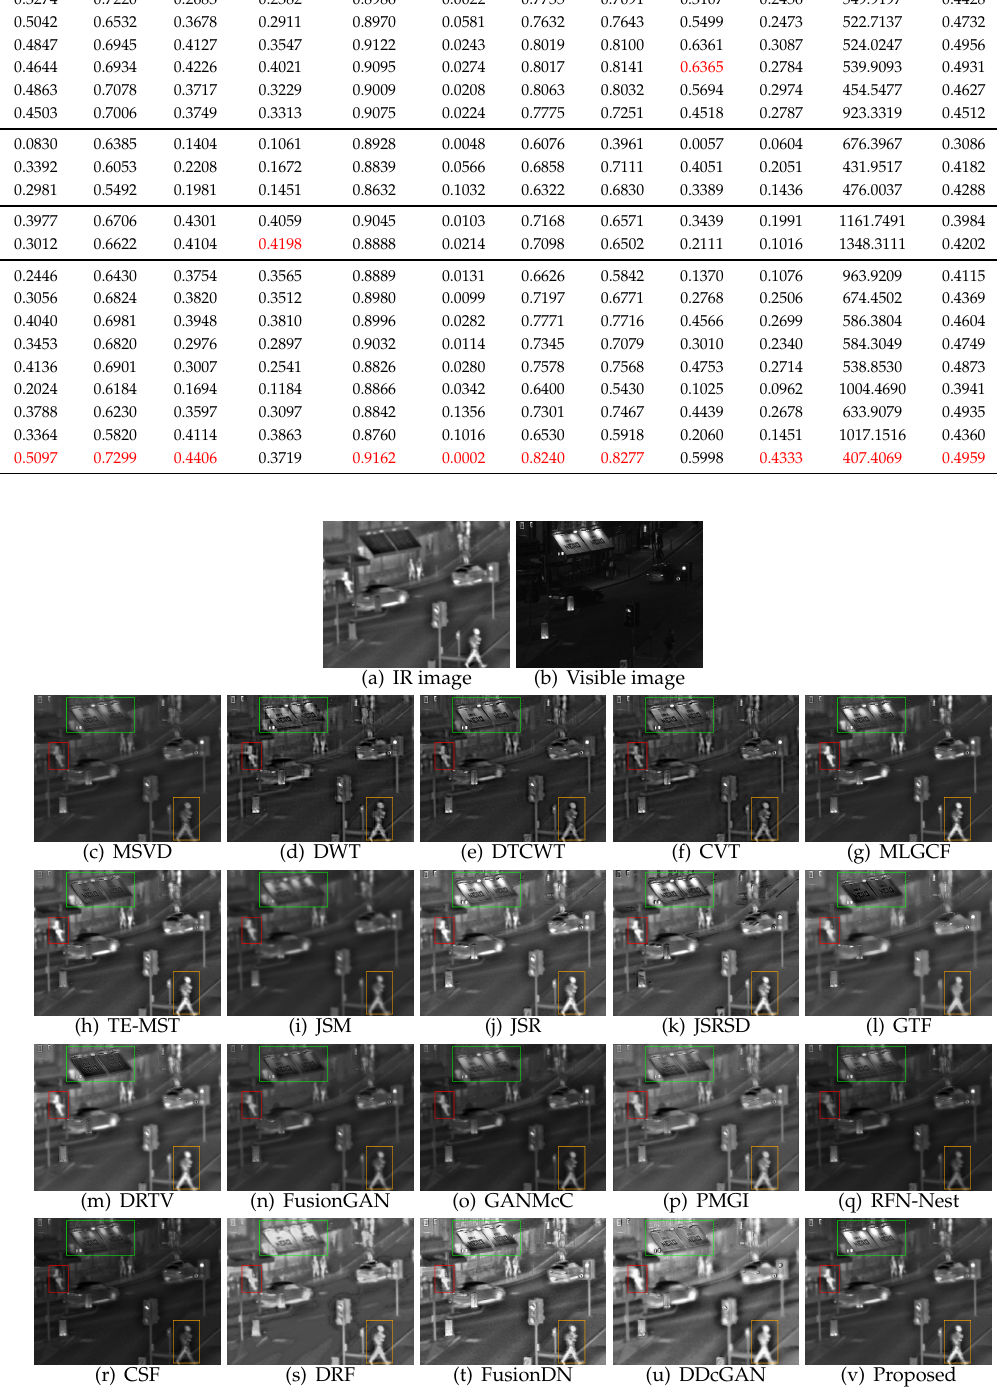
Figure 7. Fusion results of the “Queen Road” source